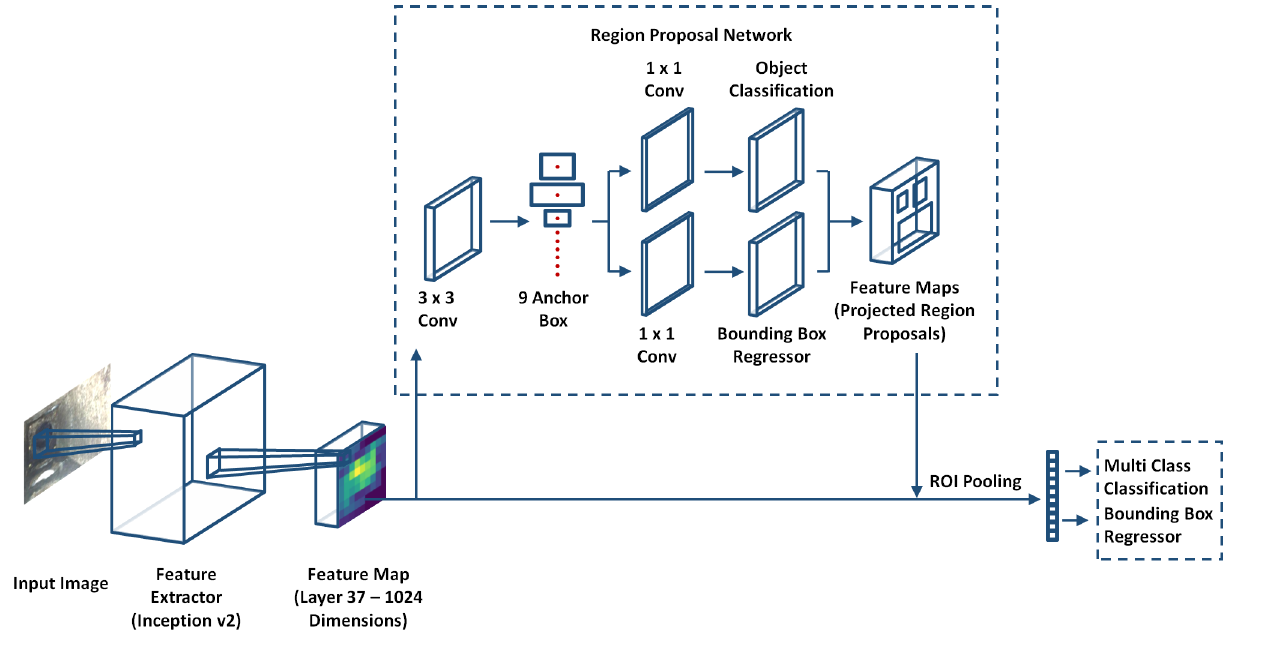
Figure 5. Functional block diagram of the deterioration detection